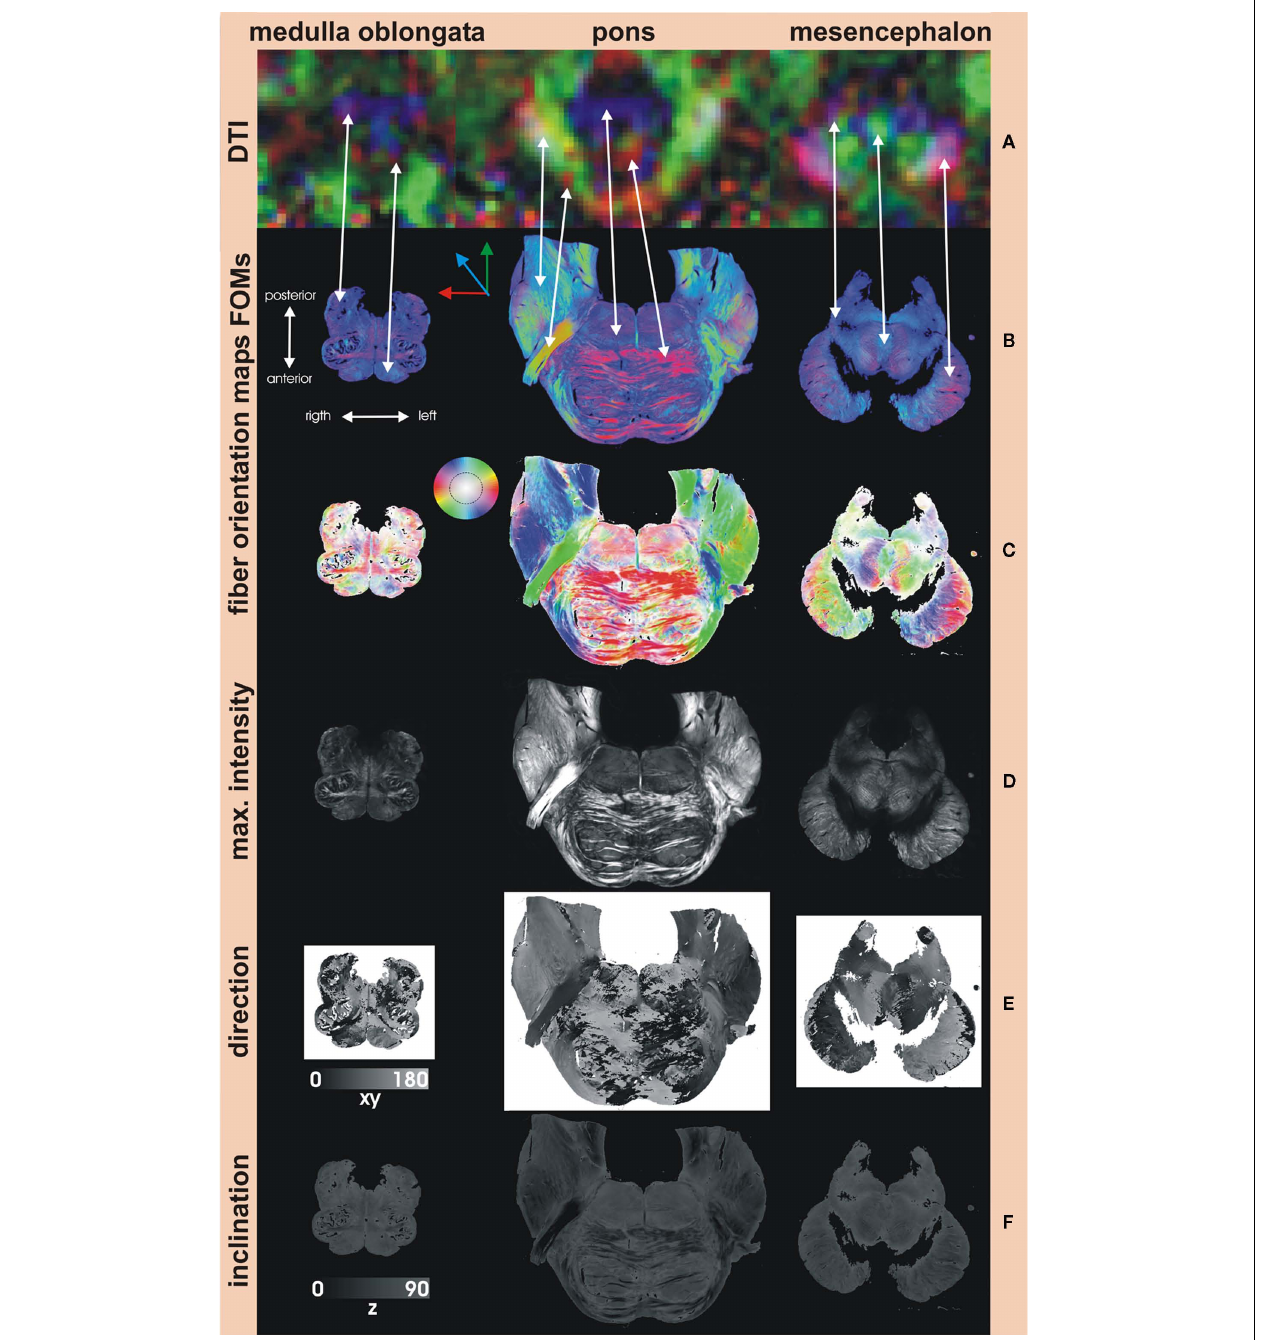
the absolute of theY component in green, and the absolute of the Z component in blue (B) . Another color scheme (C) is more beneficial for PLI data and codes in-plane orientation in color and out-of-plane rotation in intensity (inset key). Maximum intensity maps (D) show the highest intensities of each polarization sequence and give relative good anatomical contrast similar to histological myelin stains. Angles of direction (in-plane) and angles of inclination (out-of-plane) generate direction (E) and inclination maps (F) . Note that the angle of inclination can be estimated between 0˚ and 90˚ only, not distinguishable from angles between 0˚ and ( − 90˚ (inclination